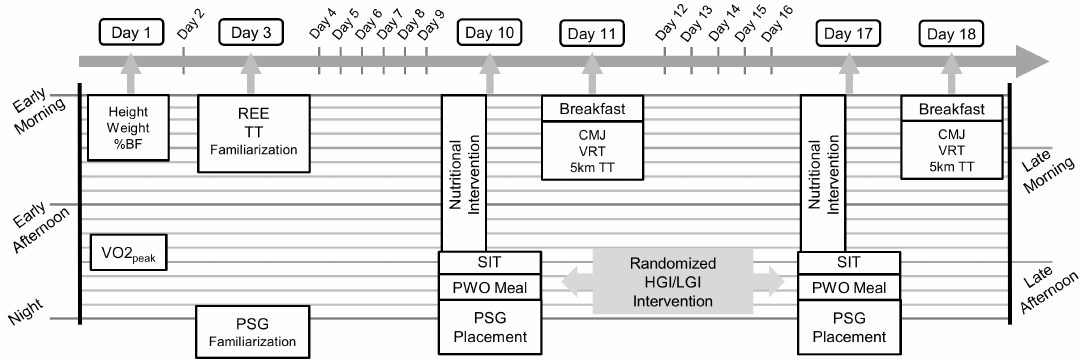
Figure 1. Schematic overview of study design. TT: time trial; REE: resting energy expenditure; PSG: polysomnography; CMJ: countermovement jump; VRT: visual reaction time, TT: time trial; PWO: post-workout; HGI: high glycemic index, LGI: low glycemic index; VO 2peak : peak oxygen uptake; SIT: sprint interval